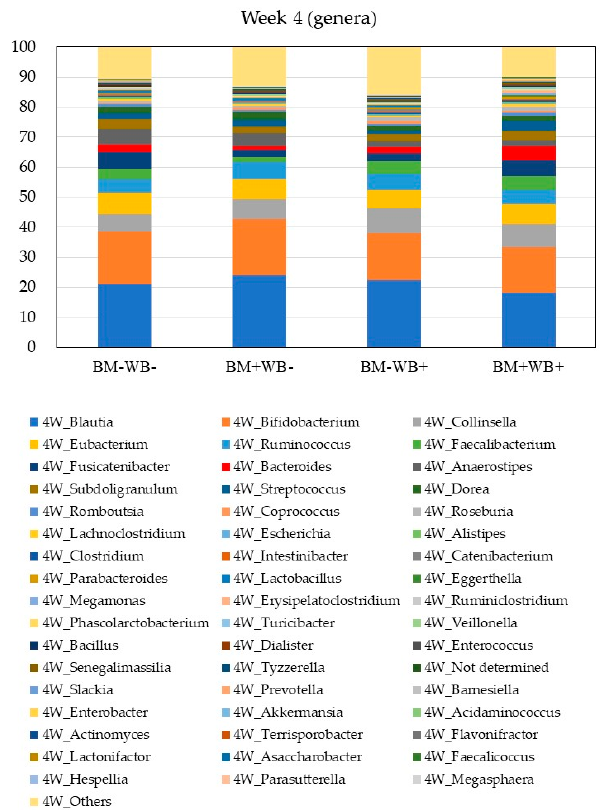
Figure 4. The average relative abundances of detected bacteria genera in stool samples obtained at week 4. A significant interactive effect of WB and BM on the abundances of Bacteroides was observed ( p < 0.05). The abundances of Anaerostipes was significantly lower in the WB+ groups than in the WB − groups at week 4 ( p < 0.05).